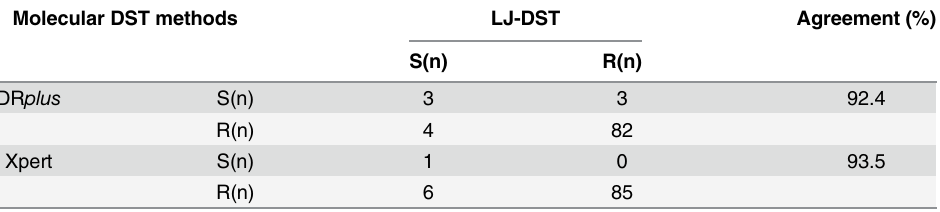
Table 1. Comparison of molecular and phenotypic DST methods for detection of RIF susceptibility, n = 92. Molecular DST